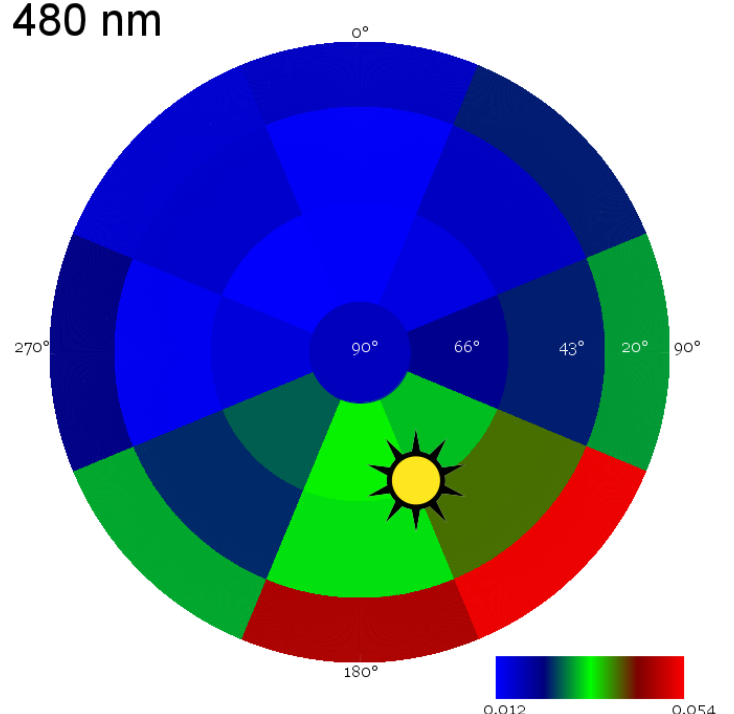
Figure 4. Reflectance of wheat at 480 nm measured at all 25 waypoints shown as a circular graph, or polar plot. Each “slice” represents a heading while each ring represents a sensor tilt angle. Spectral reflectance magnitude is color coded from low values of light blue, to high values in bright red. The angular position of the sun is depicted by the sun-symbol. In this figure no interpolation between waypoints is